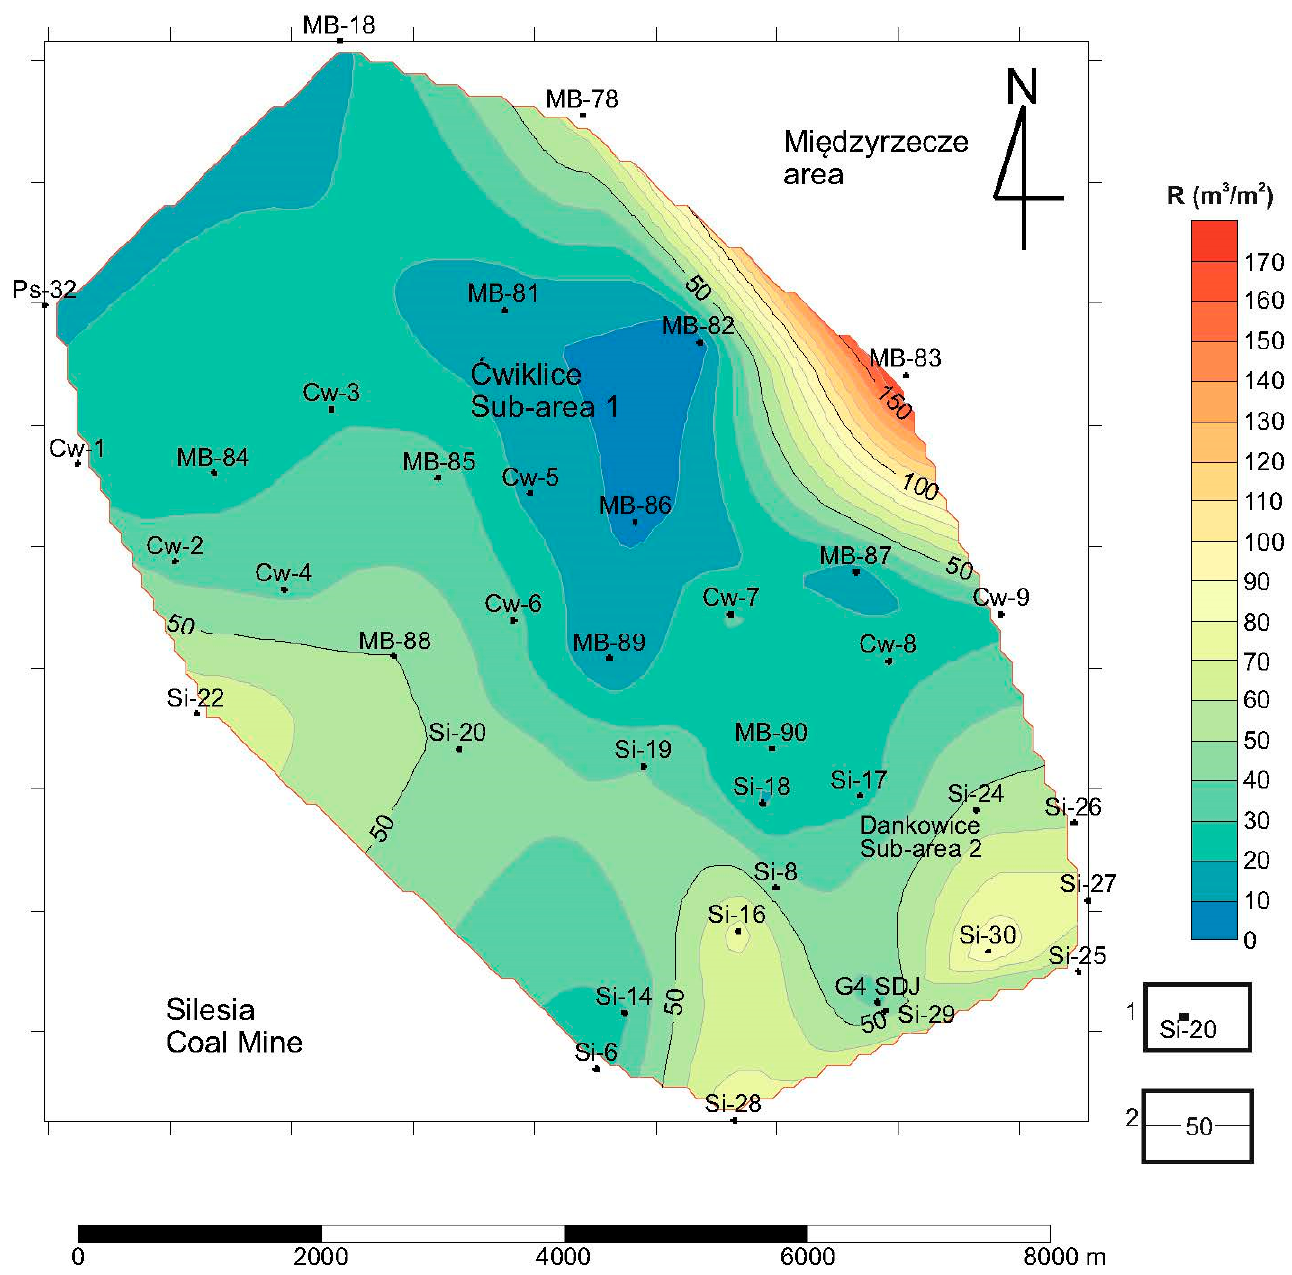
Figure 14. Methane resources in the Ć wiklice and Dankowice sub-areas at 800 m depth; 1—borehole, 2—line of methane resources (R).